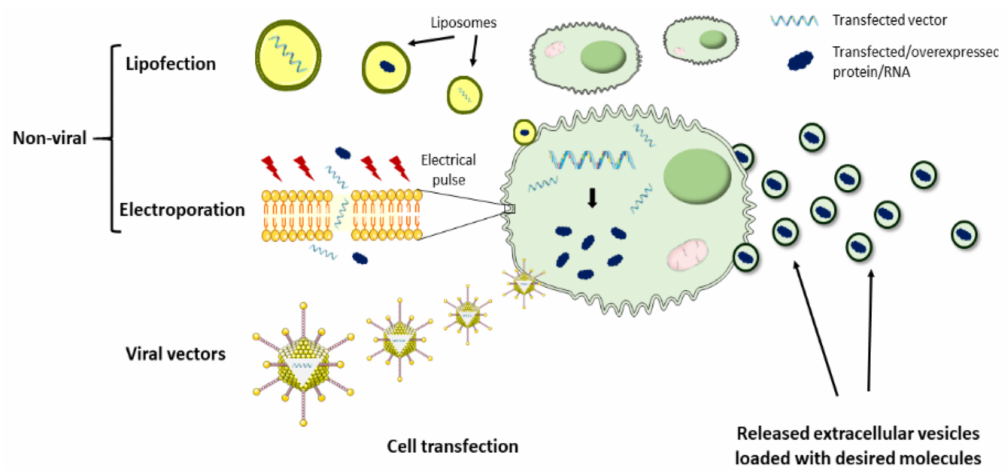
Figure 3. Summary of EVs’ cargo-loading techniques. Several approaches have been explored to efficiently load EVs with therapeutic proteins or RNAs. EVs loading may be performed by modification of donor cells or by engineering isolated EVs. Regarding EVs applied for cardiac repair, recent studies focused on the transfection of parental cells with the desired vectors/molecules by lipofection and electroporation, or in donor cell transduction using viral vectors. Subsequently, the transfected/transduced parental cells use their endogenous machinery to produce EVs loaded with that specific